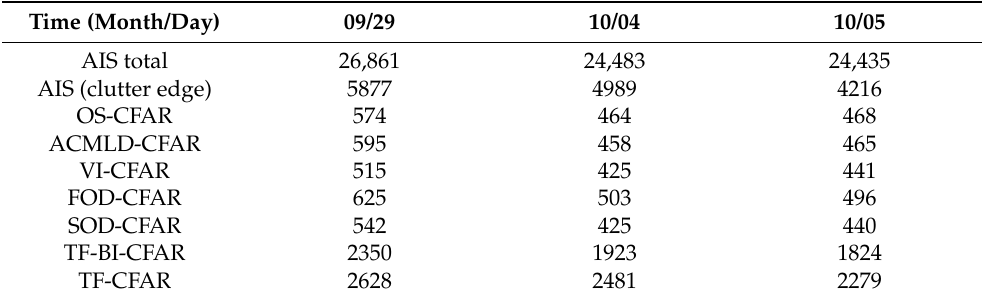
Table 5. Comparison of matched targets by TF-CFAR and other six CFAR detectors at the edge of Bragg peaks.